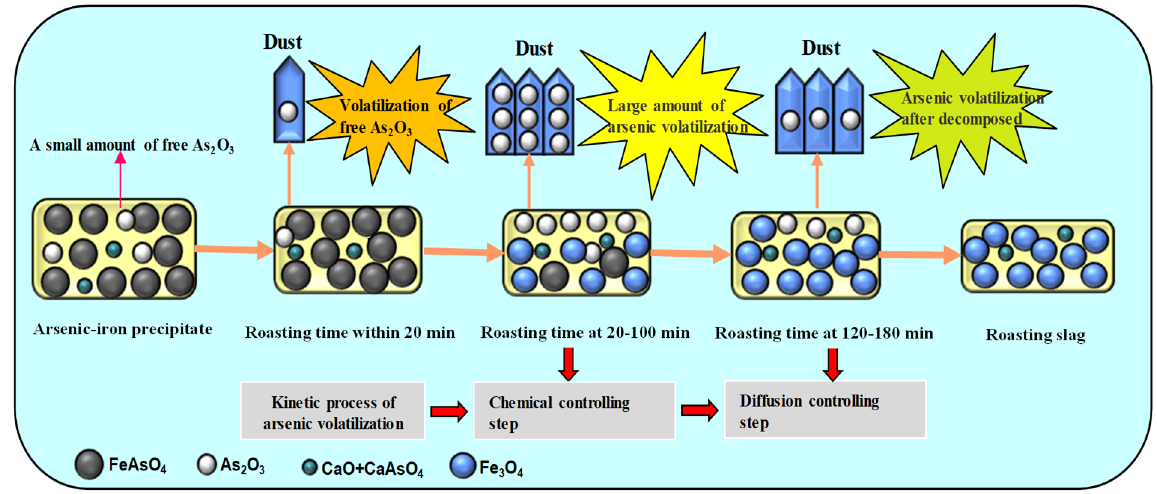
Figure 16. The reaction mechanism of arsenic and iron in carbon thermal magnetization reduction.